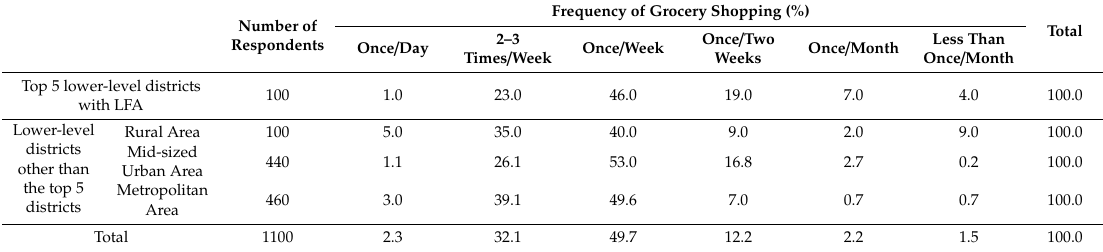
Table 7. Frequency of grocery shopping: administrative districts with and without LFA. Frequency of Grocery Shopping (%) Number of Total / Two / Month Less Than Respondents Once / Day 2–3 Times / Week Once / Week Once Weeks Once Once / Month Top 5 lower-level districts with LFA 100 1.0 23.0 46.0 19.0 7.0 4.0 100.0 Lower-level Rural Area 100 5.0 35.0 districts other than the top 5 districts Total 1100